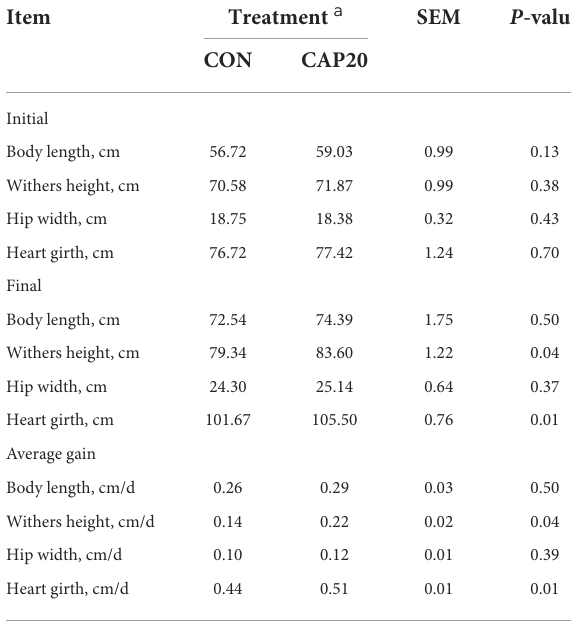
TABLE 4 Blood parameters of calves born from dams supplemented either 0 or 20 mg/kg dry matter of Capsicum oleoresin